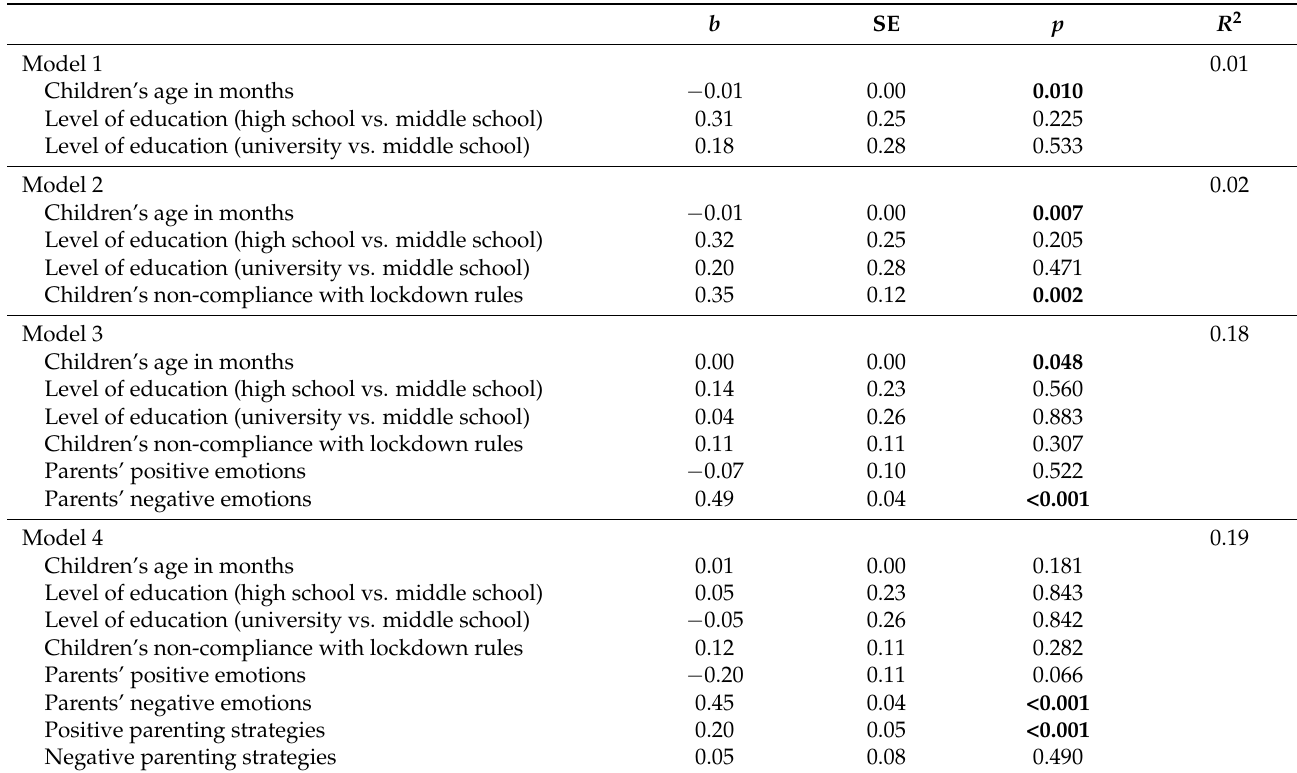
Table 3. Summary of hierarchical regression analysis on children’s internalizing